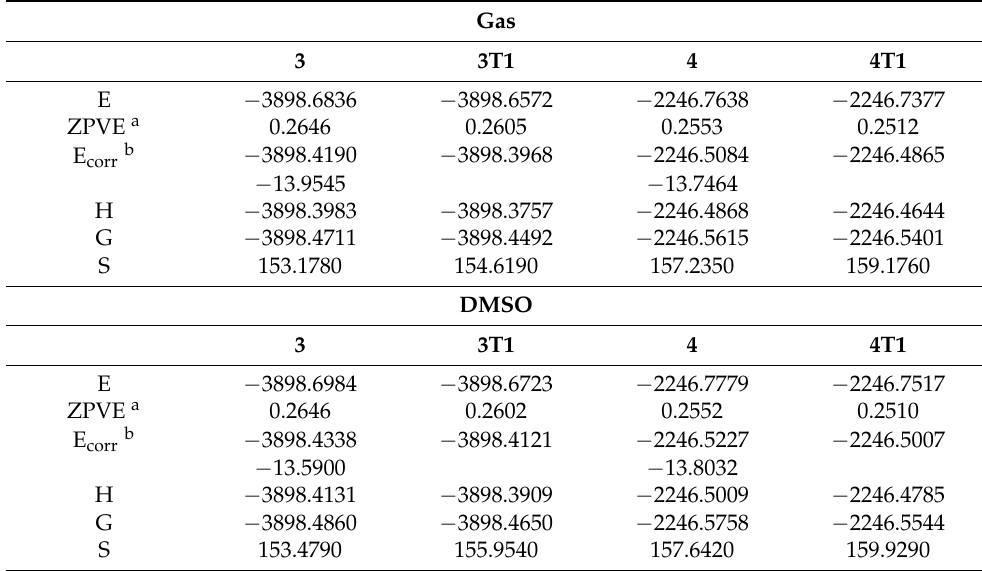
Table 6. Calculated total energies and thermodynamic properties of the thione and thiol tautomers of the studied